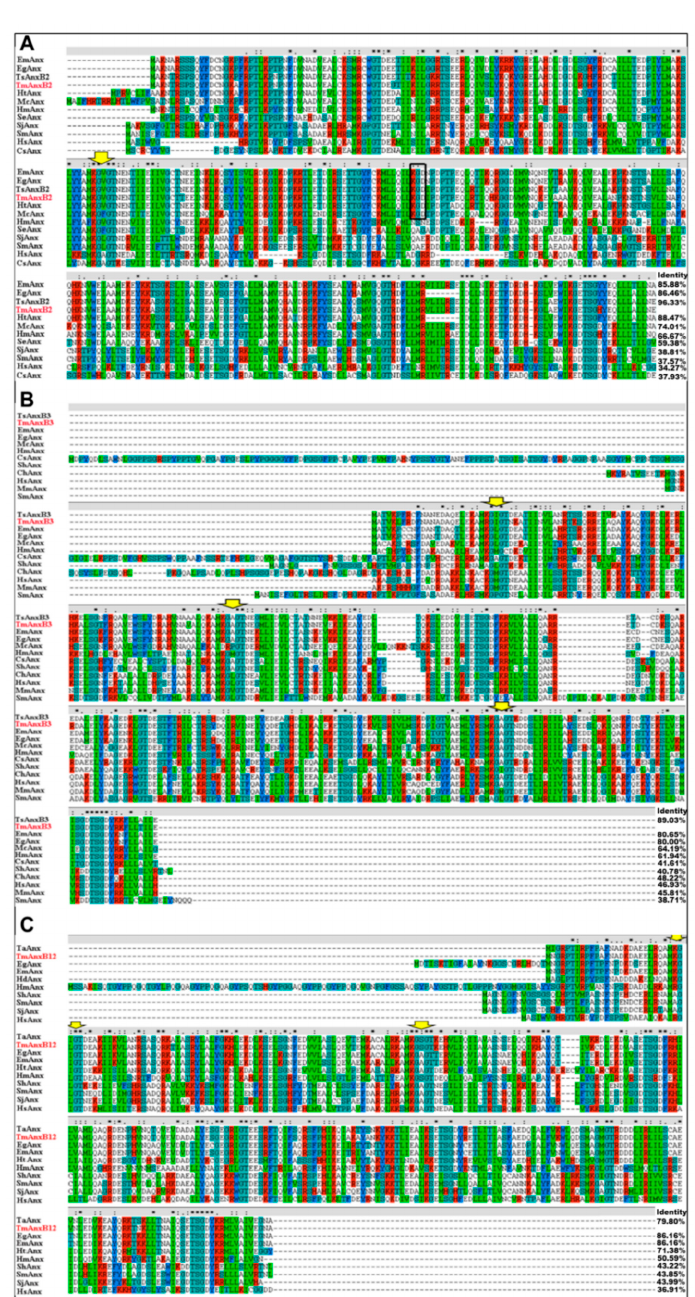
Figure 1. Sequence alignment analyses of: AnxB2 ( A ); AnxB3 ( B ); and AnxB12 ( C ) in T. multiceps and other species. ( A ) The following sequences were retrieved from the GenBank protein sequence database (accession numbers are indicated in parentheses): Em, Echinococcus multilocularis (CDI98110.1); Eg, Echinococcus granulosus (CDS21833.1); Ts, Taenia solium (AAY17503.1); Ht, Hydatigena taeniaeformis (A0A0R3X1T1); Mc, Mesocestoides corti (A0A0R3UMC3); Hm, Hymenolepis microstoma